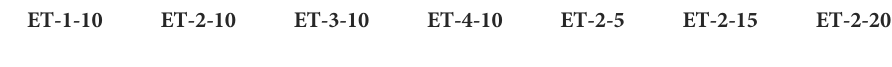
TABLE 2 Setting of working conditions of sand